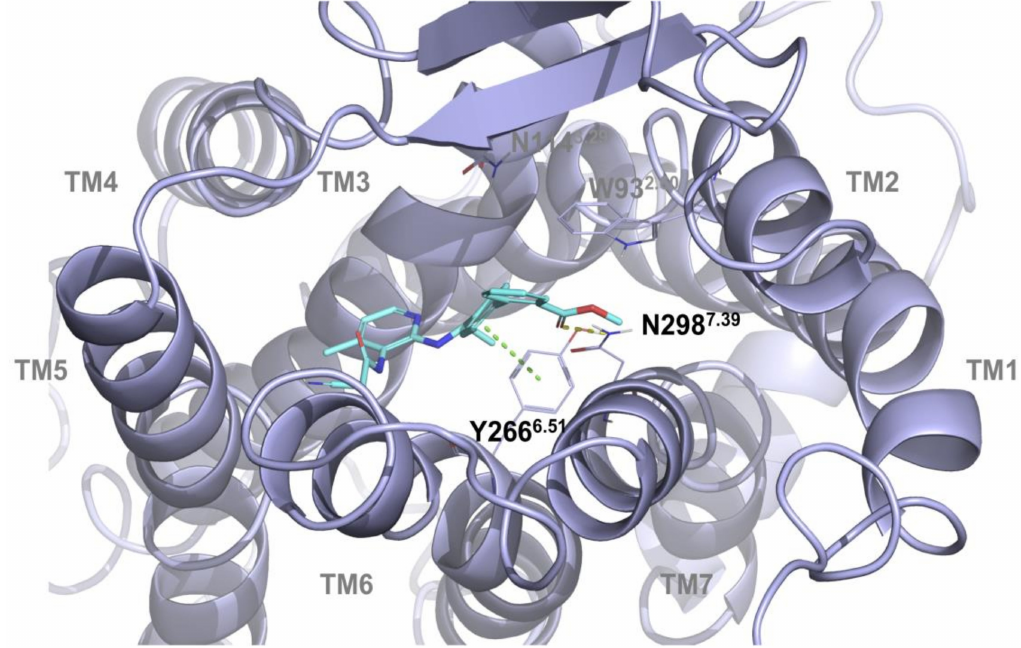
Figure 3. 3D representation of Merck compound 14 binding the B1 receptor pocket. Merck compound 14 is reported in cyan sticks, protein and binding site residues (colored in slate) are represented as cartoon and lines respectively, whereas hydrogen bond and pi-pi interactions are reported in yellow and green dashes respectively. In the figure are shown the interaction of the carbonyl moiety of methyl ester group with N298 7.39 and the pi-pi interaction between the Merck compound and residue Y266 6.51 . Labels are reported with Ballesteros–Weinstein numbering